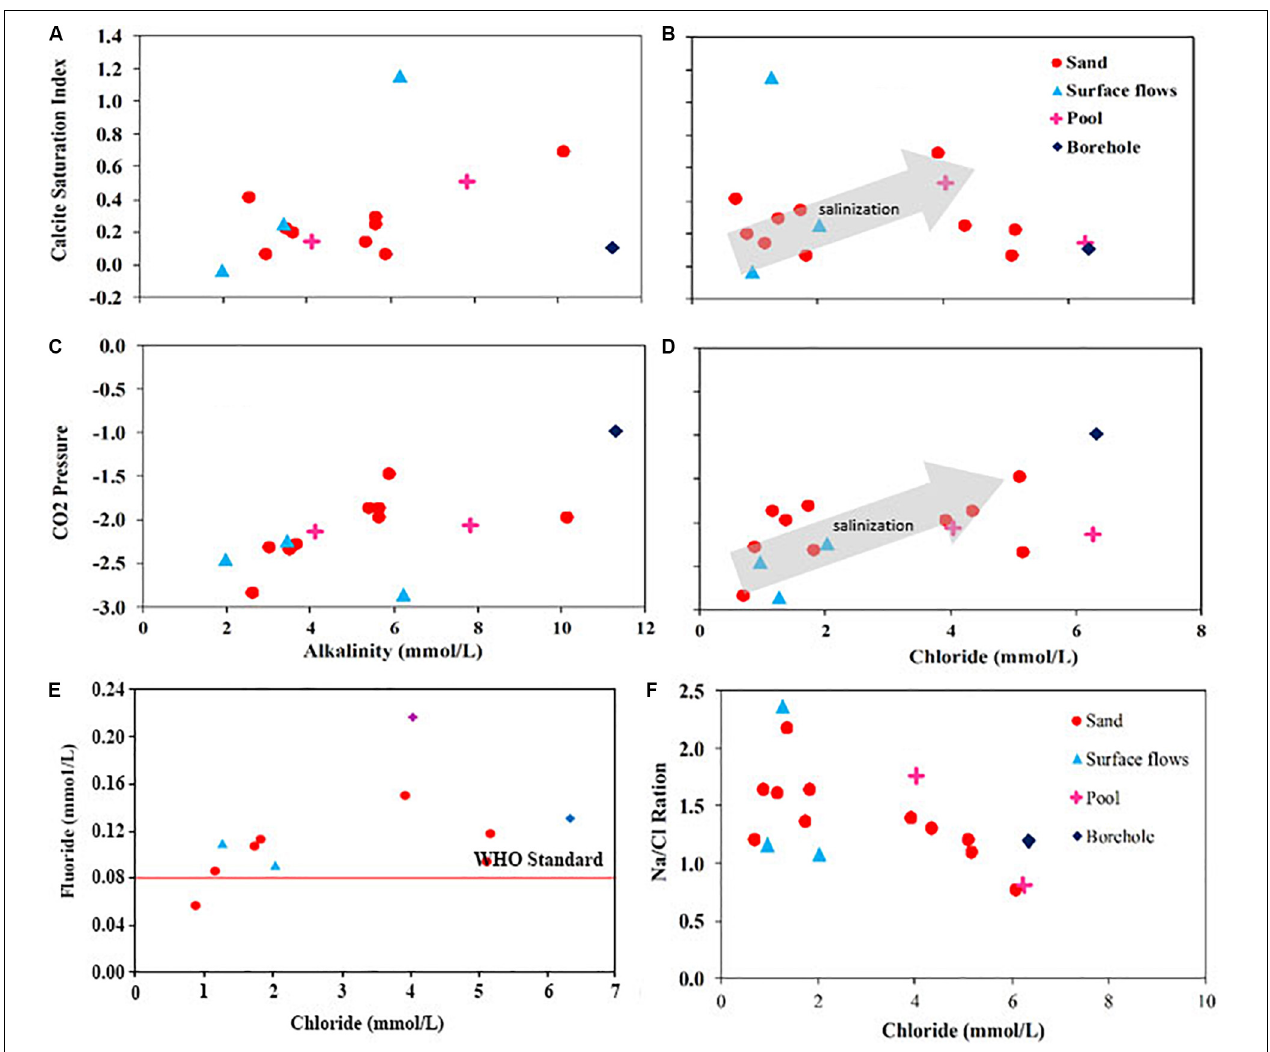
FIGURE 8 | Scatter plots for calcite saturation vs. alkalinity (A) and chloride (B) , CO2 pressure vs. alkalinity (C) and chloride (D) , fluoride vs. chloride (E) and Na/Cl ratio vs. chloride (F)